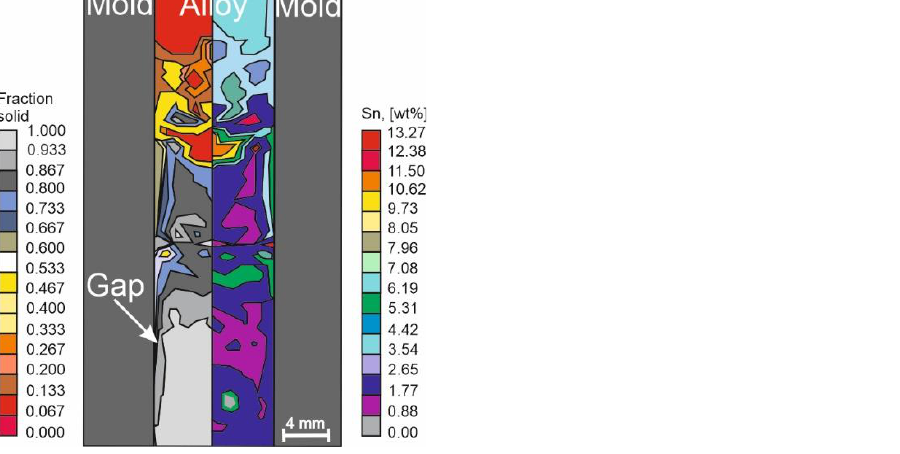
Figure 19. Schematic simulation results of solid–liquid interface morphology and Sn distribution [37]. Luo et al. [38] used Cu-4.7 wt%Sn to determine the flow of fluid and heat during the TZCC process. An alloy, 10 mm in diameter, was selected for this purpose. The speed of continuous casting, melting temperature, mould temperature, and the cooling water temperature were set to 20 mm/min, 1200 ◦ C, 1040 ◦ C, and 18 ◦ C, respectively. The temper- ature of the alloy varied from 720 to 1081 ◦ C. A complex circular flow caused by convection was observed in the mould. This facilitated the flow of the liquid alloy in the down- ward direction along the wall of the mould, followed by an upward flow in the centre. Analysing the direction of heat flow revealed that, at the centre, the flow was vertically downwards; at the upper wall, the flow was obliquely downwards, which was deflected towards the mould; and at the lower wall, the flow was deflected away from the